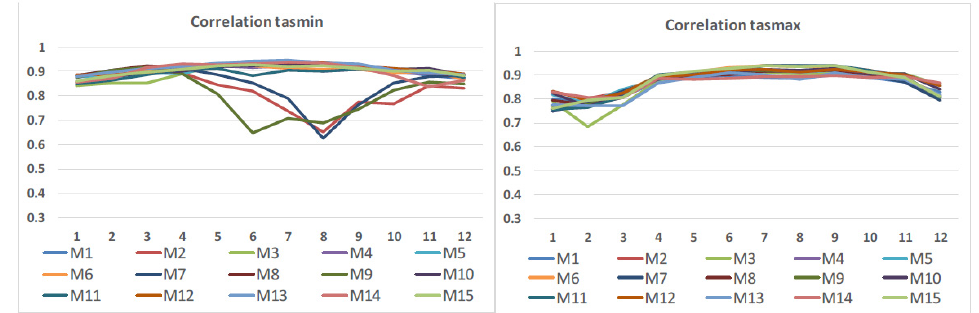
Figure 5. Pearson correlation for tasmin ( left ) and tasmax ( right ) between EURO-CORDEX simulations (full names of individual models are given in Table 1) and ROCADA observation-derived datasets over the period 1971–2000.